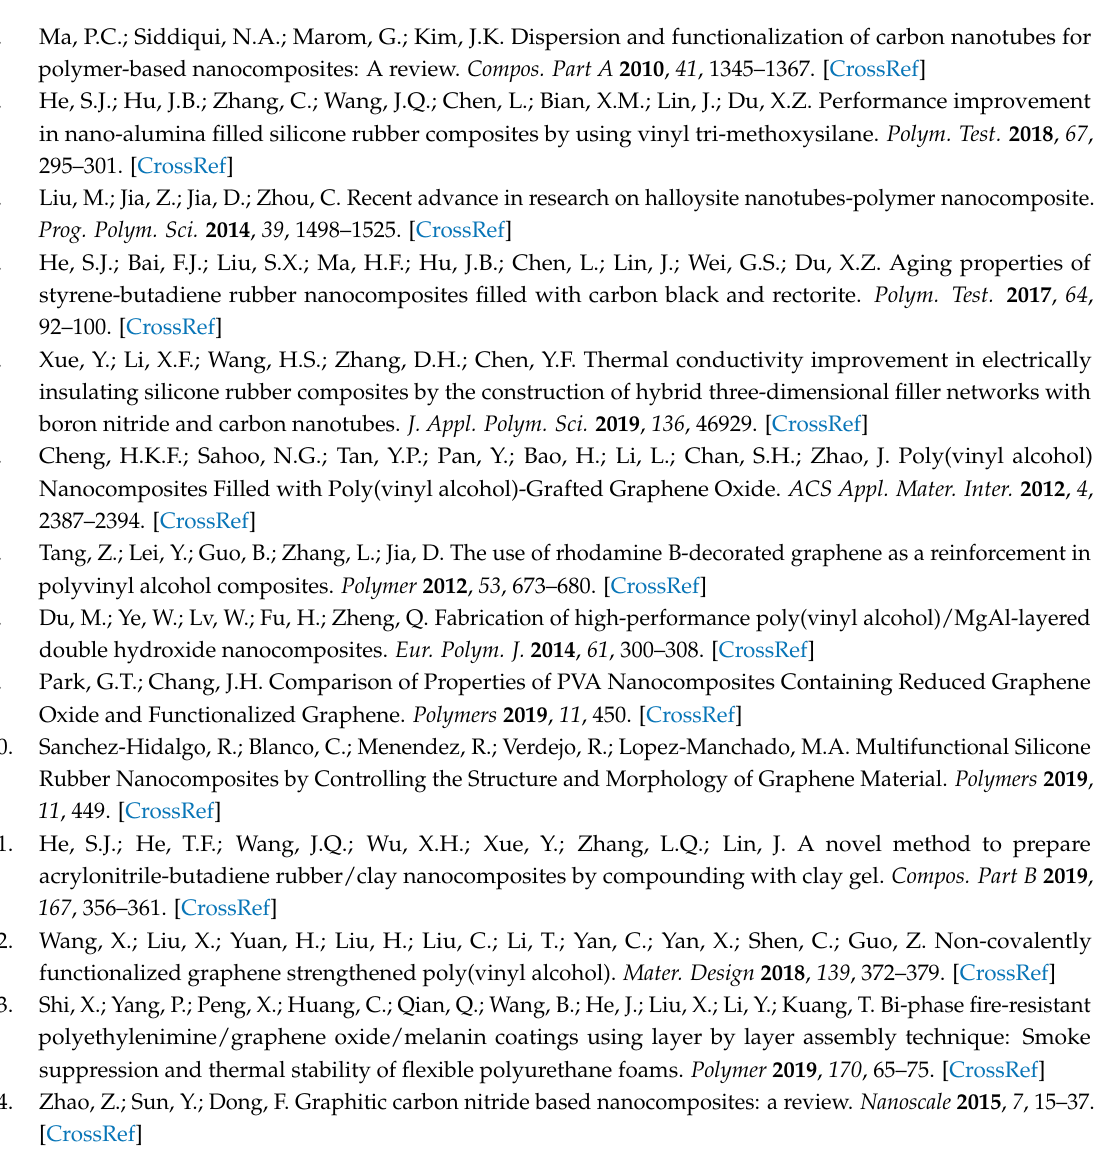
Figure S1: (a) XRD and (b) FTIR curves of melamine, bulk g-C3N4 and g-C3N4 nanosheets; Figure S2: XPS (a) survey scan, (b) N1s, (c) C1s and (d) O1s of g-C3N4